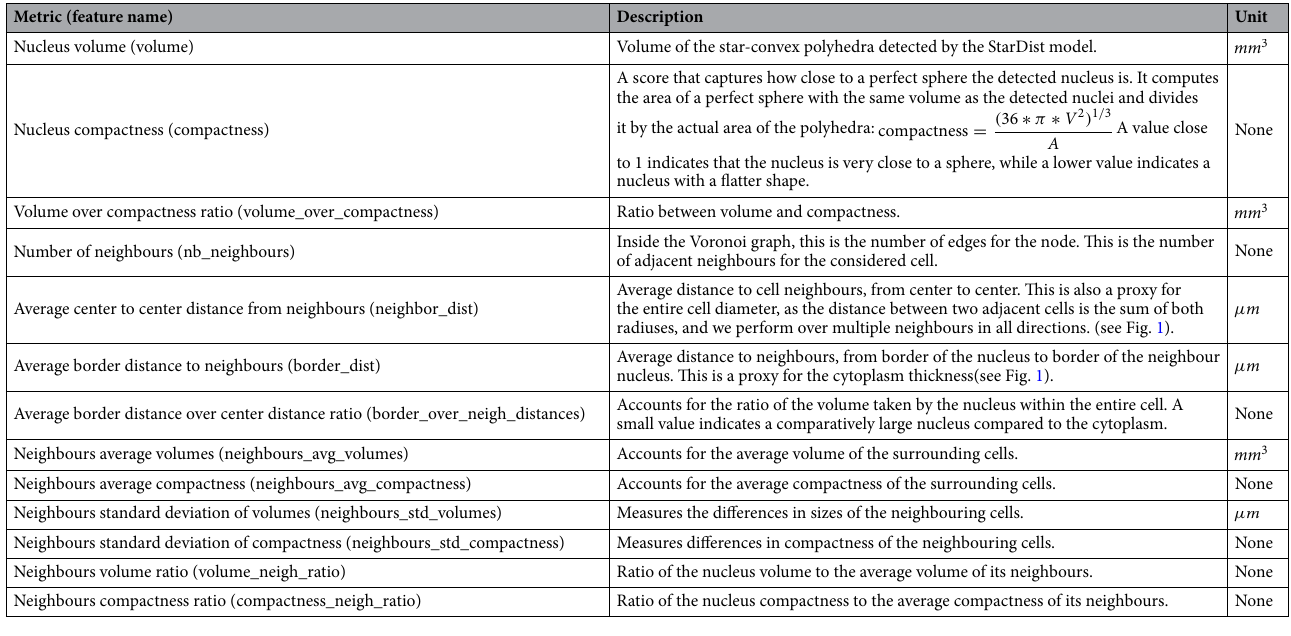
Table 2. Cell level metrics, list and